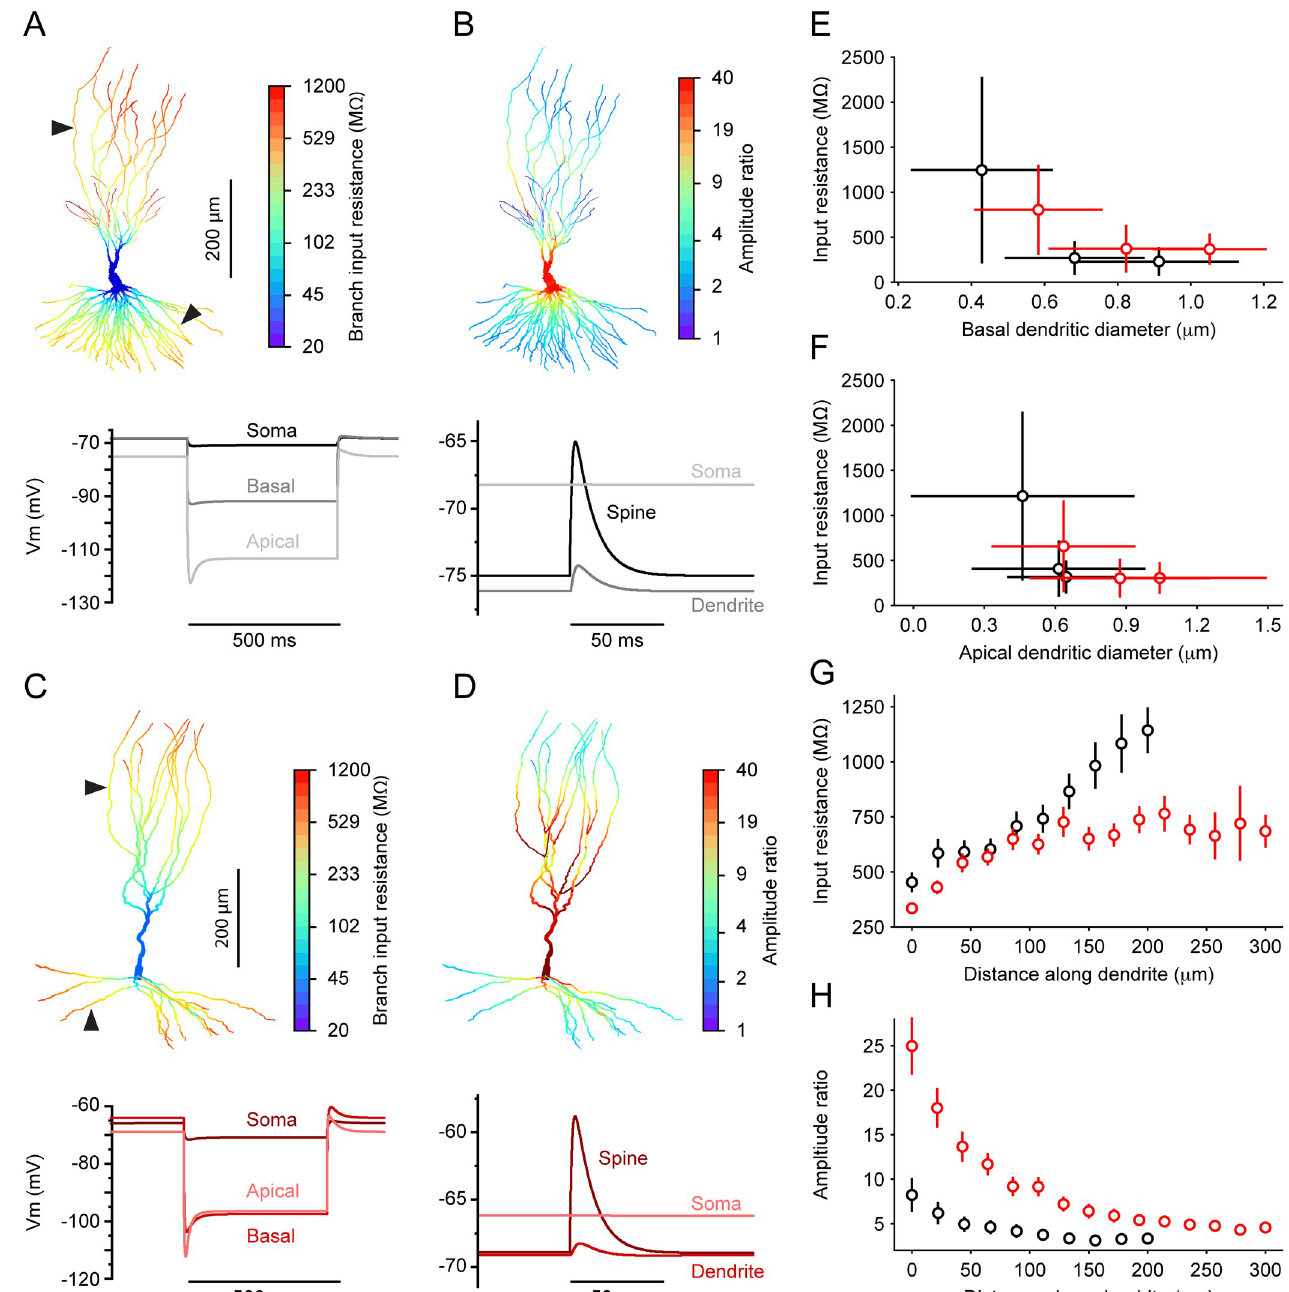
Fig 4. Distinct dendritic properties of cell type specific models. (A) Representative distribution of branch input resistance (R in ) values in one of the thorny morphologies considered in this study. Top: warmer colors indicate higher values of R in and black arrowheads indicate the recording locations for the sample voltage traces shown at the bottom of panels (A) and (B). Bottom: example voltage traces in response to the injection of a 500 ms-long hyperpolarizing current in the soma and in one compartment of the apical and basal dendrites. (B) Representative distribution of amplitude ratio values in the same individual shown in (A). Top: warmer colors indicate higher values of amplitude ratio and have an inverse relationship to R in . Bottom: example voltage traces recorded in the spine head, dendrite shaft and soma in response to the injection in the spine head of an EPSP-shaped current whose amplitude was dynamically adjusted to cause a Vm deflection in the spine of approximately 10 mV. (C, D) Same as (A, B), but for a representative individual of the a-thorny cell type. Notice how the highest values of R in in the thorny cells are located in the apical obliques while in the a-thorny cells R in generally increases with distance from the soma. (E, F) R in as a function of basal and apical dendrite diameter for the three morphologies shown in Fig 2 for each of the cell types. Dots and bars indicate mean and standard deviation, respectively. (G) R in as a function of the distance along distal apical dendrites (i.e., unbranched stretches of dendrites comprised between a bifurcation and the tip of the dendrite) for thorny and a-thorny cells (black and red markers, respectively). Dots and bars indicate mean and SEM, respectively, computed over the morphologies shown in Fig 2. (H) Same as (G), but for the amplitude ratio of synaptic inputs.